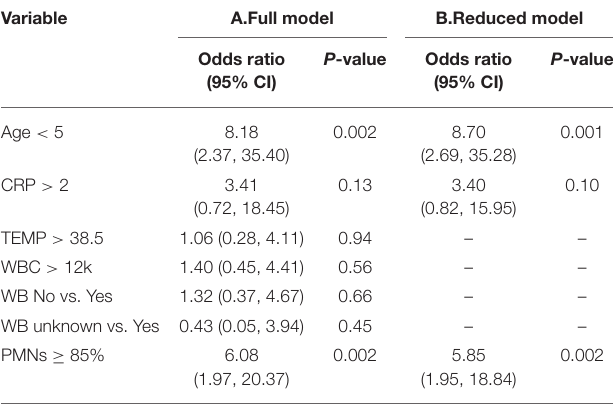
TABLE 3 | The logistic regression results, septic knee ( n = 64) vs. aseptic knee ( n = 29), new septic knee model with (A) all the pre-specified variables and (B) reduced set of variables (subset with non-missing